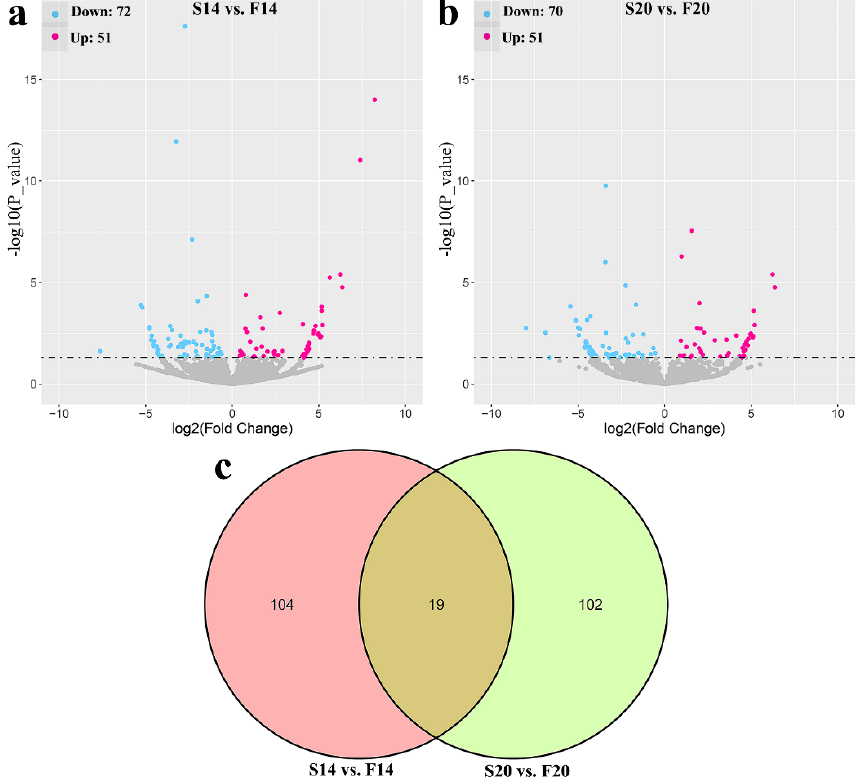
Figure 1. Statistics of differentially expressed circRNAs (DECs). ( a ) Volcano plot of DECs in S14 vs. F14 group. ( b ) Volcano plot of DECs in S20 vs. F20 group. ( c ) Venn diagram of DECs.